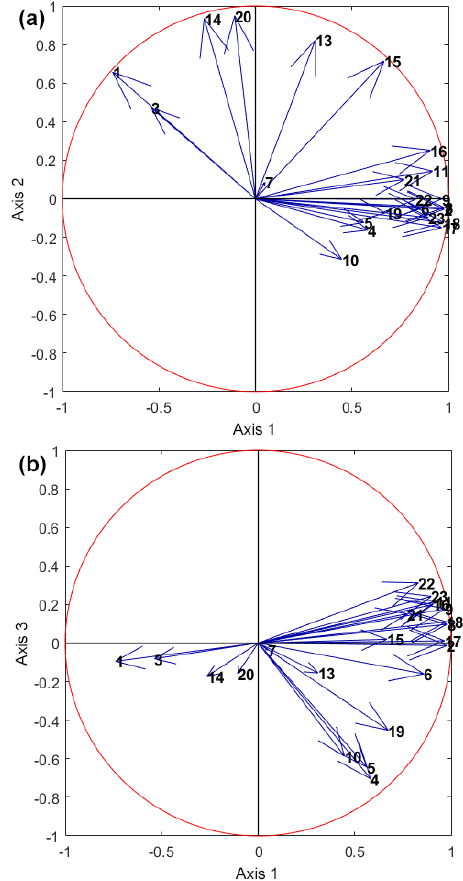
Figure 1. PCA on the learning data set based on the 23 variables described in Table 3. (a) Correlation circle on axes 1 and 2. (b) Cor- relation circle on axes 1 and 3. All of the variables are normalized according to the last column of Table